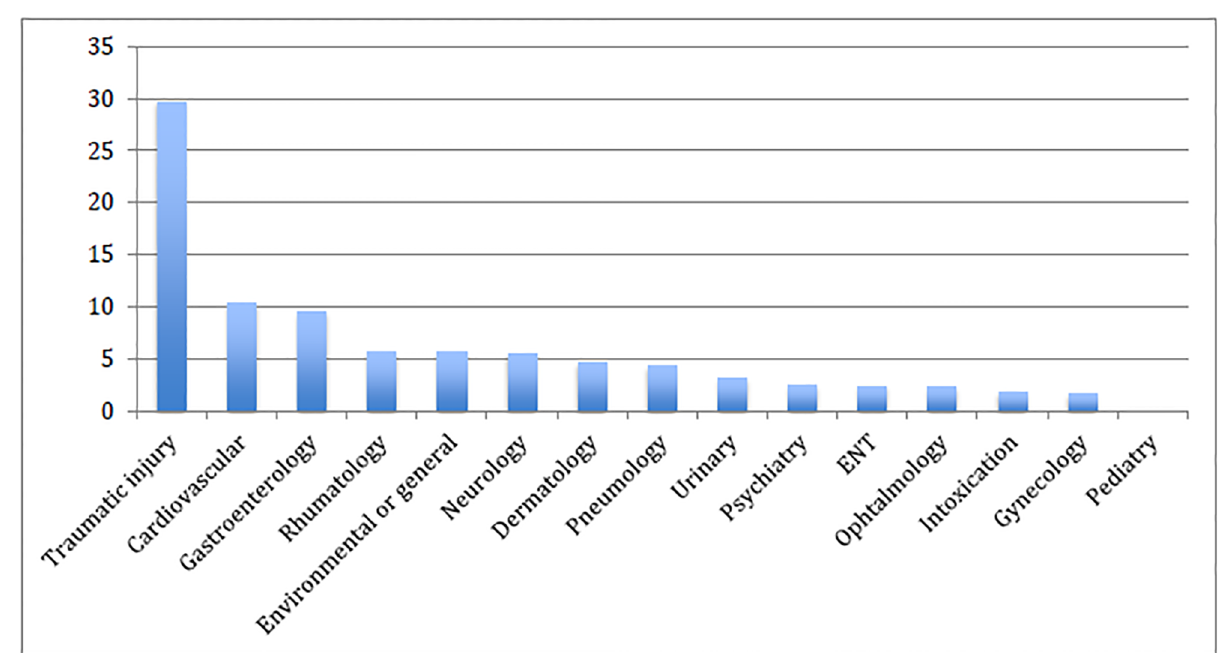
Fig 1. Type of chief complaint of user older than 15